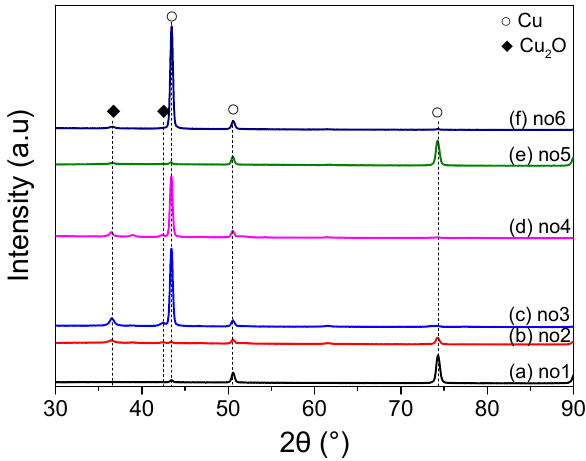
Figure 4. XRD patterns of Cu specimens after 3 weeks immersion test in ( a ) solution no1, ( b ) solution no2, ( c ) solution no3, ( d ) solution no4, ( e ) solution no5, and ( f ) solution no6.